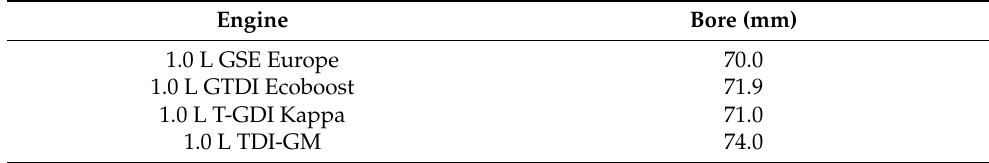
Table 2. Modern 1.0 L engines bore size